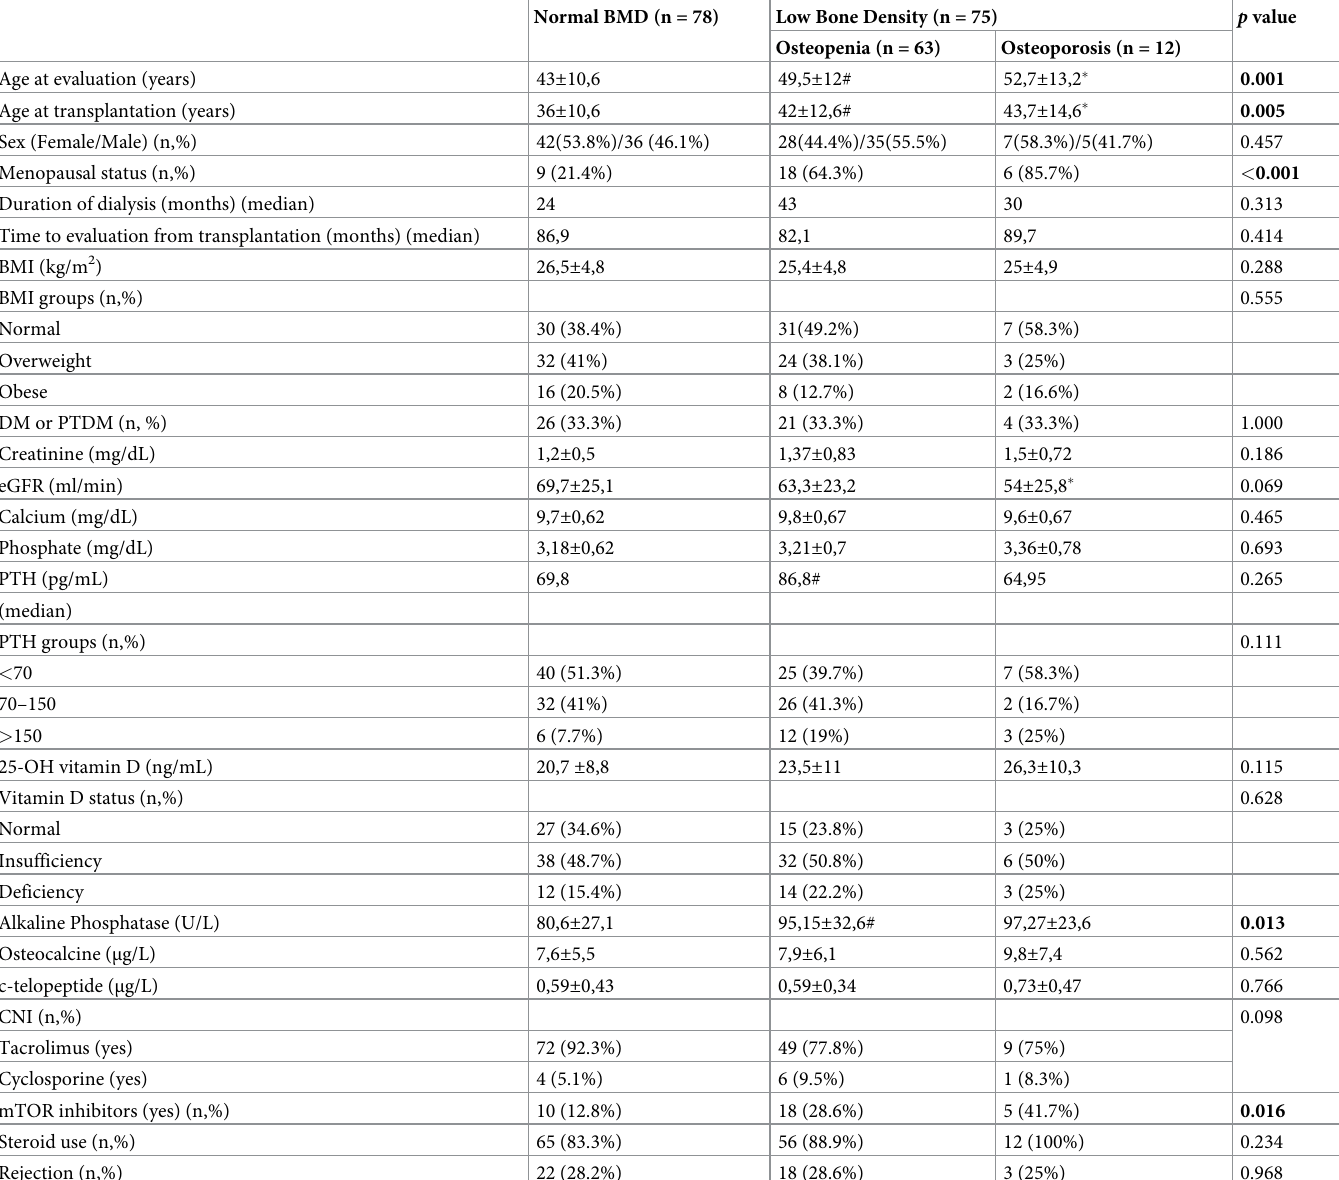
Table 2. Comparison of the patients’ demographic and clinical parameters regarding BMD